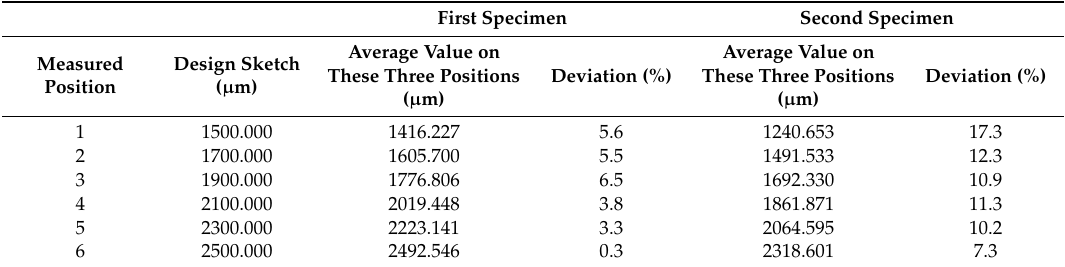
Table 3. Measured data on the first part of the two specimens printed by the first two scanning